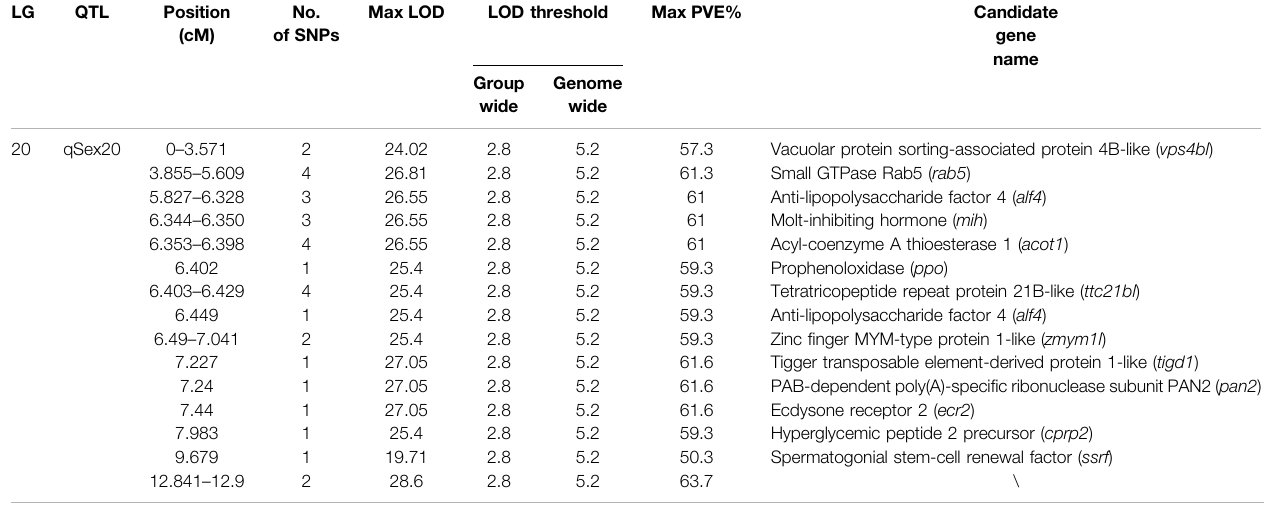
TABLE 4 | Summary information of sex-related QTL and candidate genes.